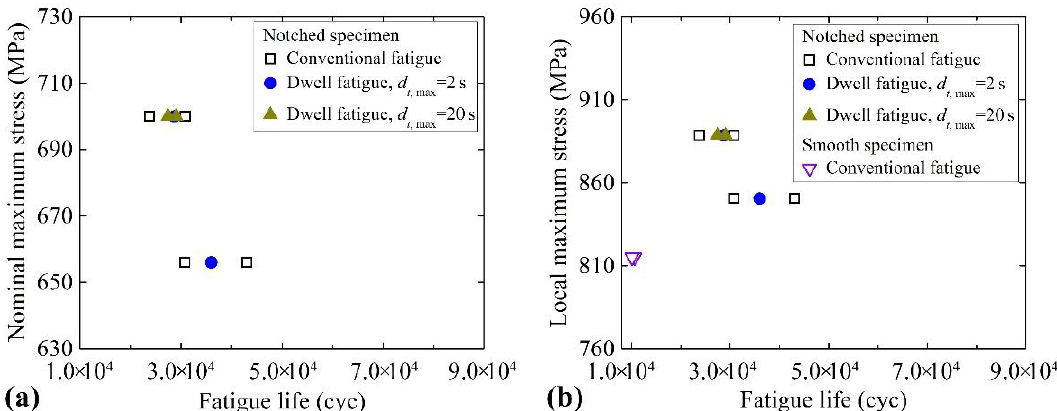
Figure 5. Comparison of fatigue performance between dwell fatigue test and conventional fatigue test for notched specimens. ( a ) Nominal maximums stress and fatigue life; ( b ) local maximum stress and fatigue life, which is also compared with the conventional fatigue life of the smooth specimen.